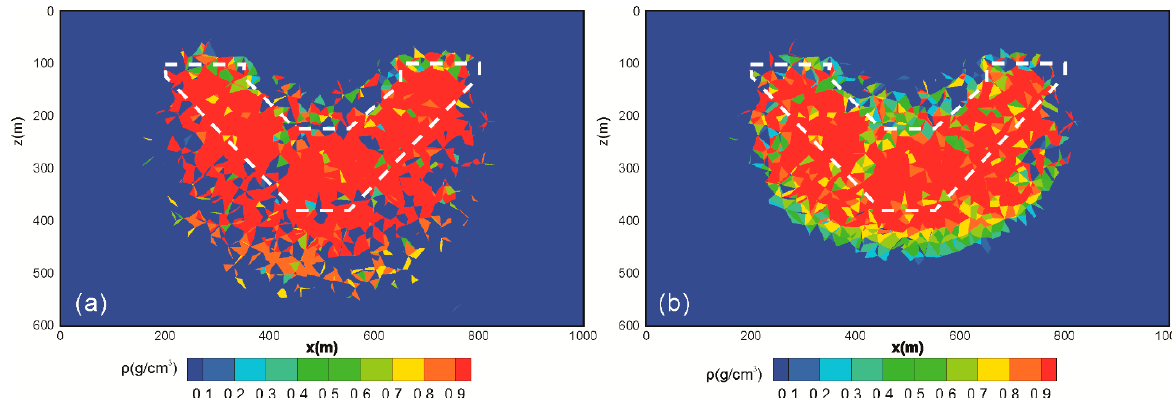
Figure 7. Inversion results with gradient-based strategy: ( a ) focusing inversion, and ( b ) conventional FCM clustering in- version.